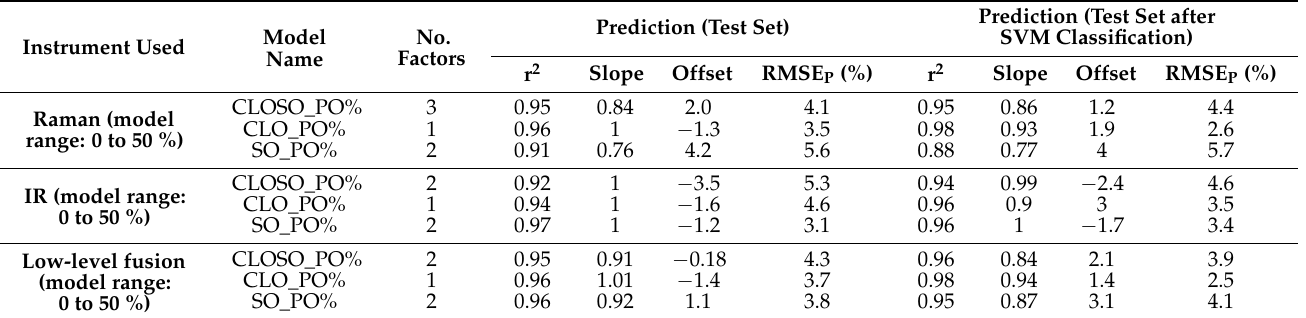
Table 2. Test set performance for PLSR-based quantitative assessment of PO adulteration in CLO and